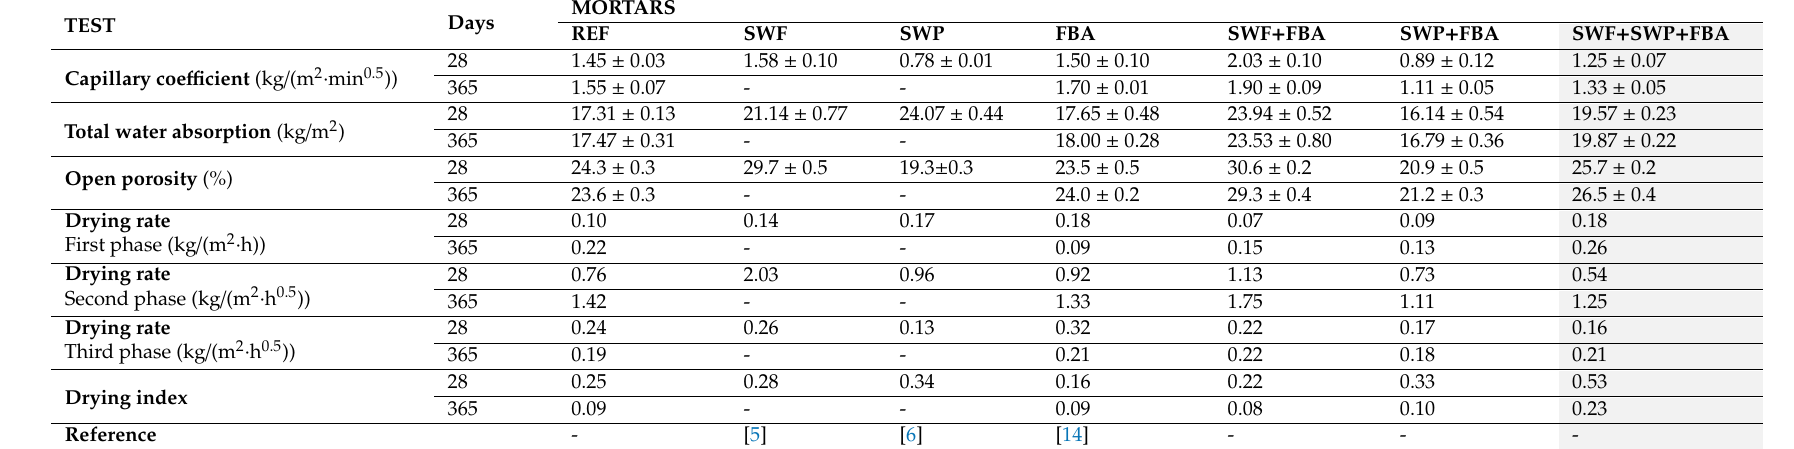
Table 2. Water absorption and open porosity test